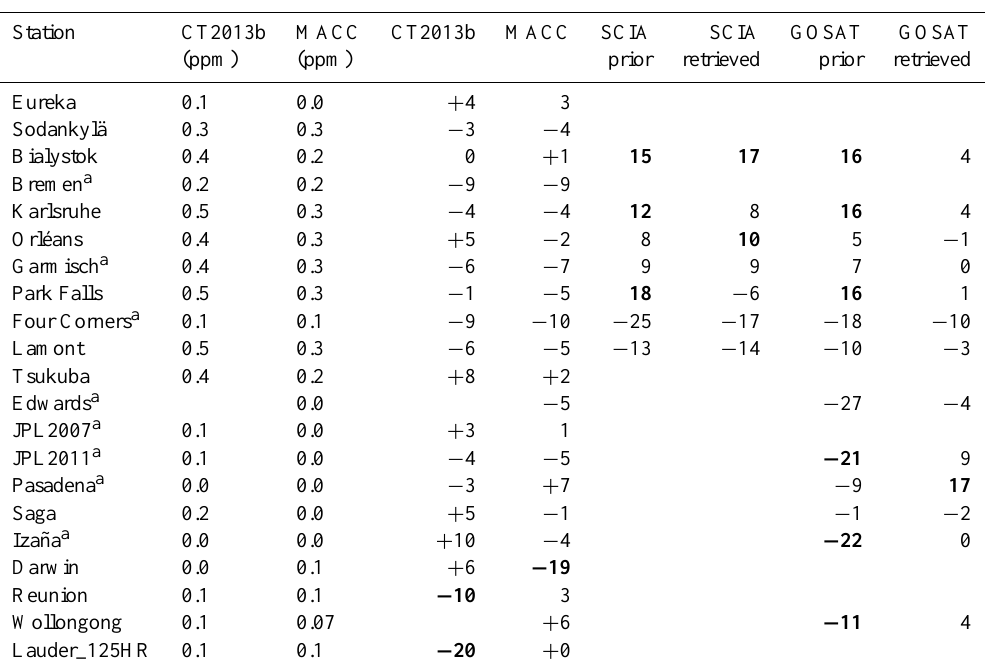
a indicates TCCON stations which are locally influenced (see Sect.